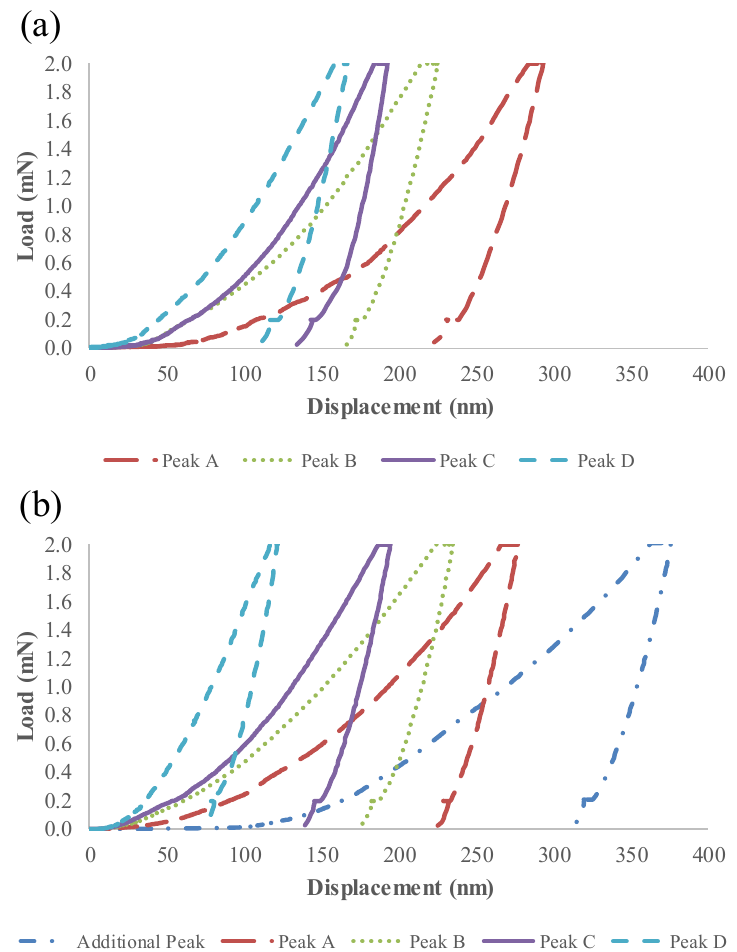
Figure 5. Load displacement curves for the mechanically distinct peaks identified in ( a ) the reference cement paste and ( b ) the cement paste with CNFs.